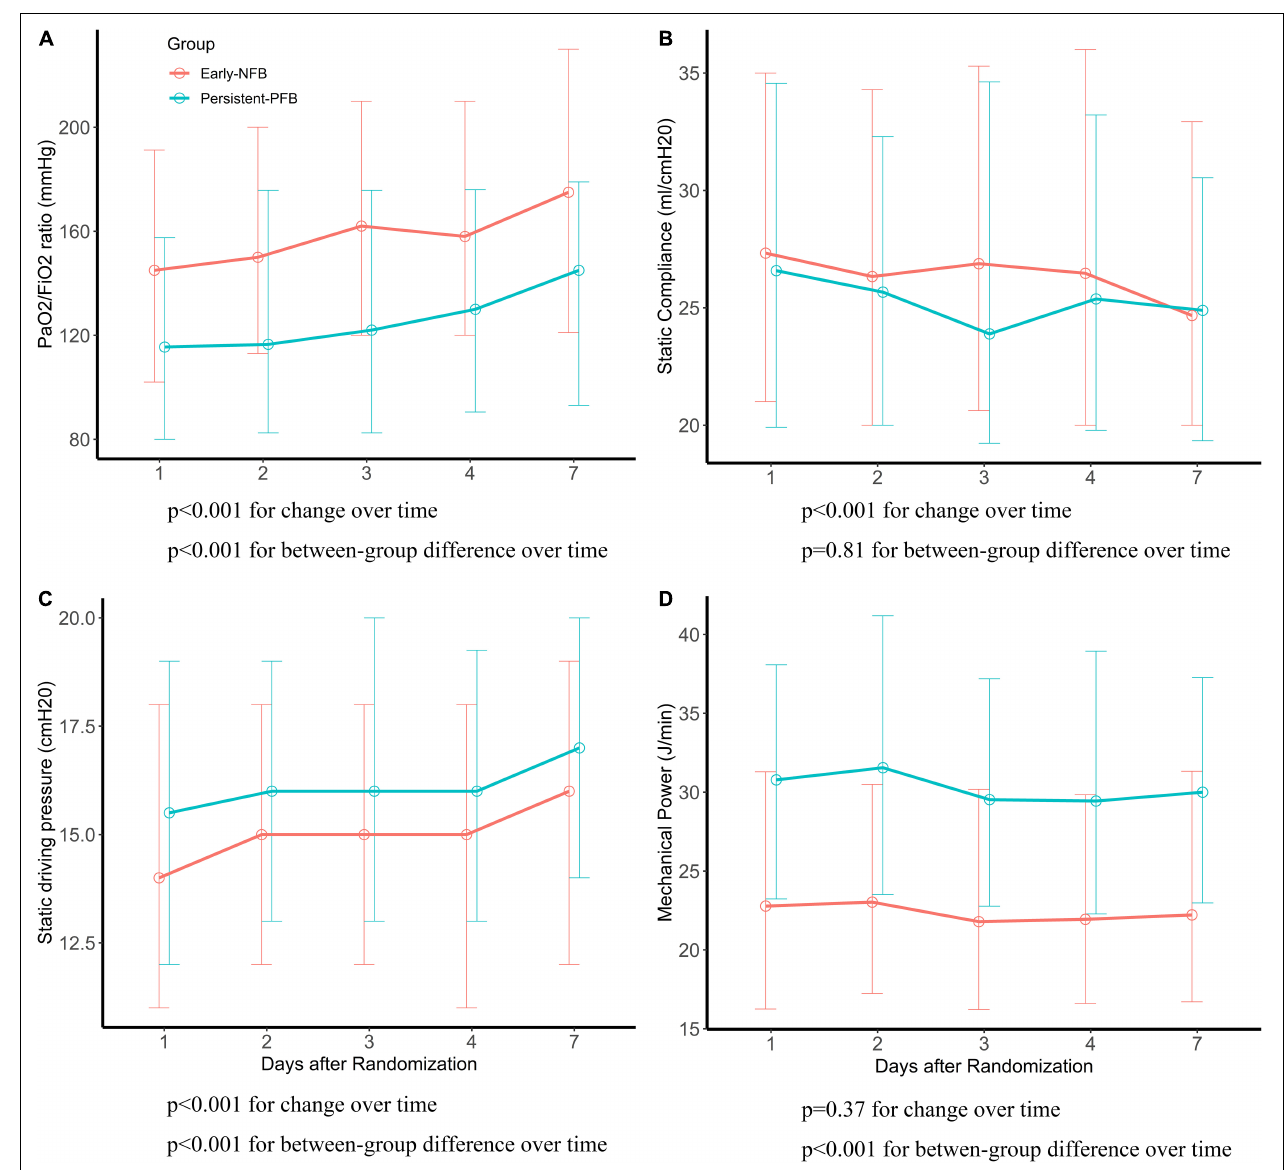
FIGURE 2 | The difference of respiratory parameters between phenotypes. P -values for differences with time and for between-group differences using liner mixed effects model. (A) PaO 2 /FiO 2 (mmHg), (B) static compliance (ml/cmH 2 O), (C) static driving pressure (cmH 2 O), (D) mechanical power